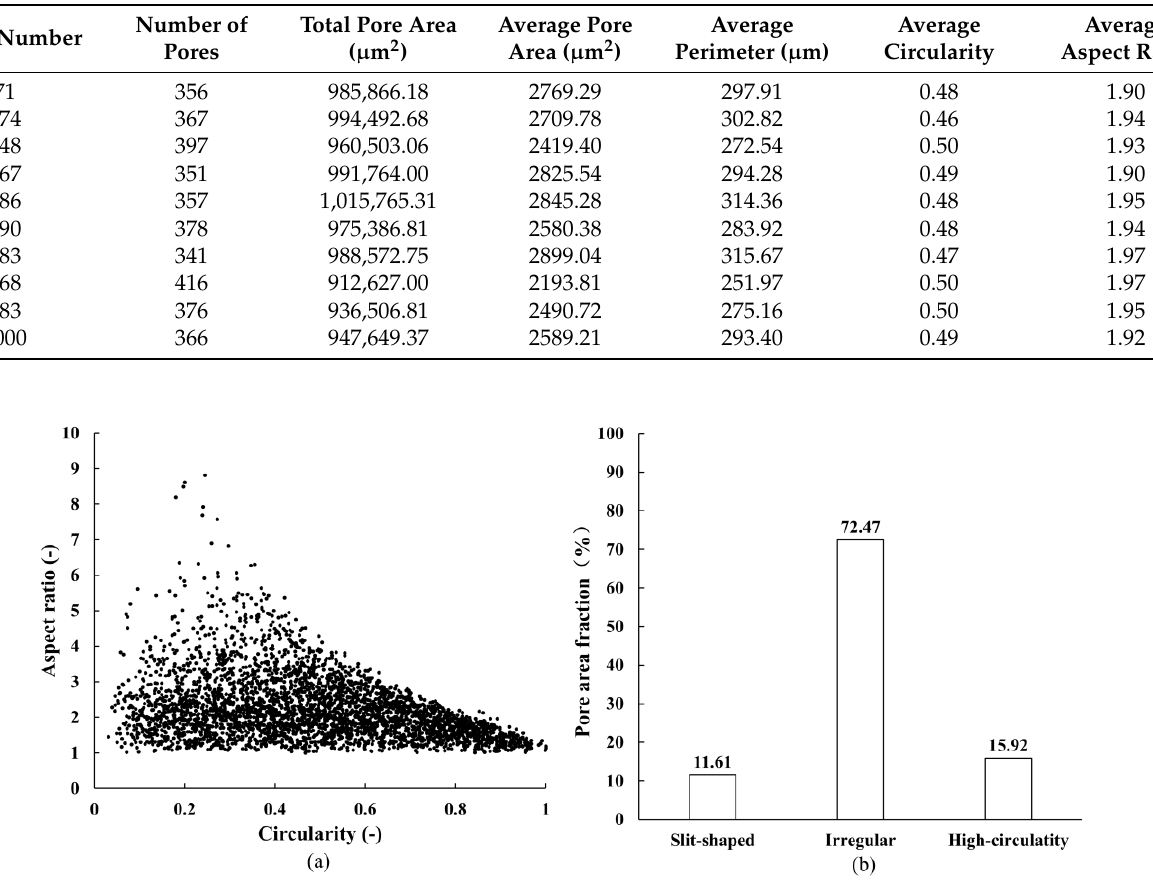
Figure 5. ( a ) Relationship between aspect ratios and circularity values of pores; ( b ) area fractions of slit-shaped, irregular and high-circularity pores.